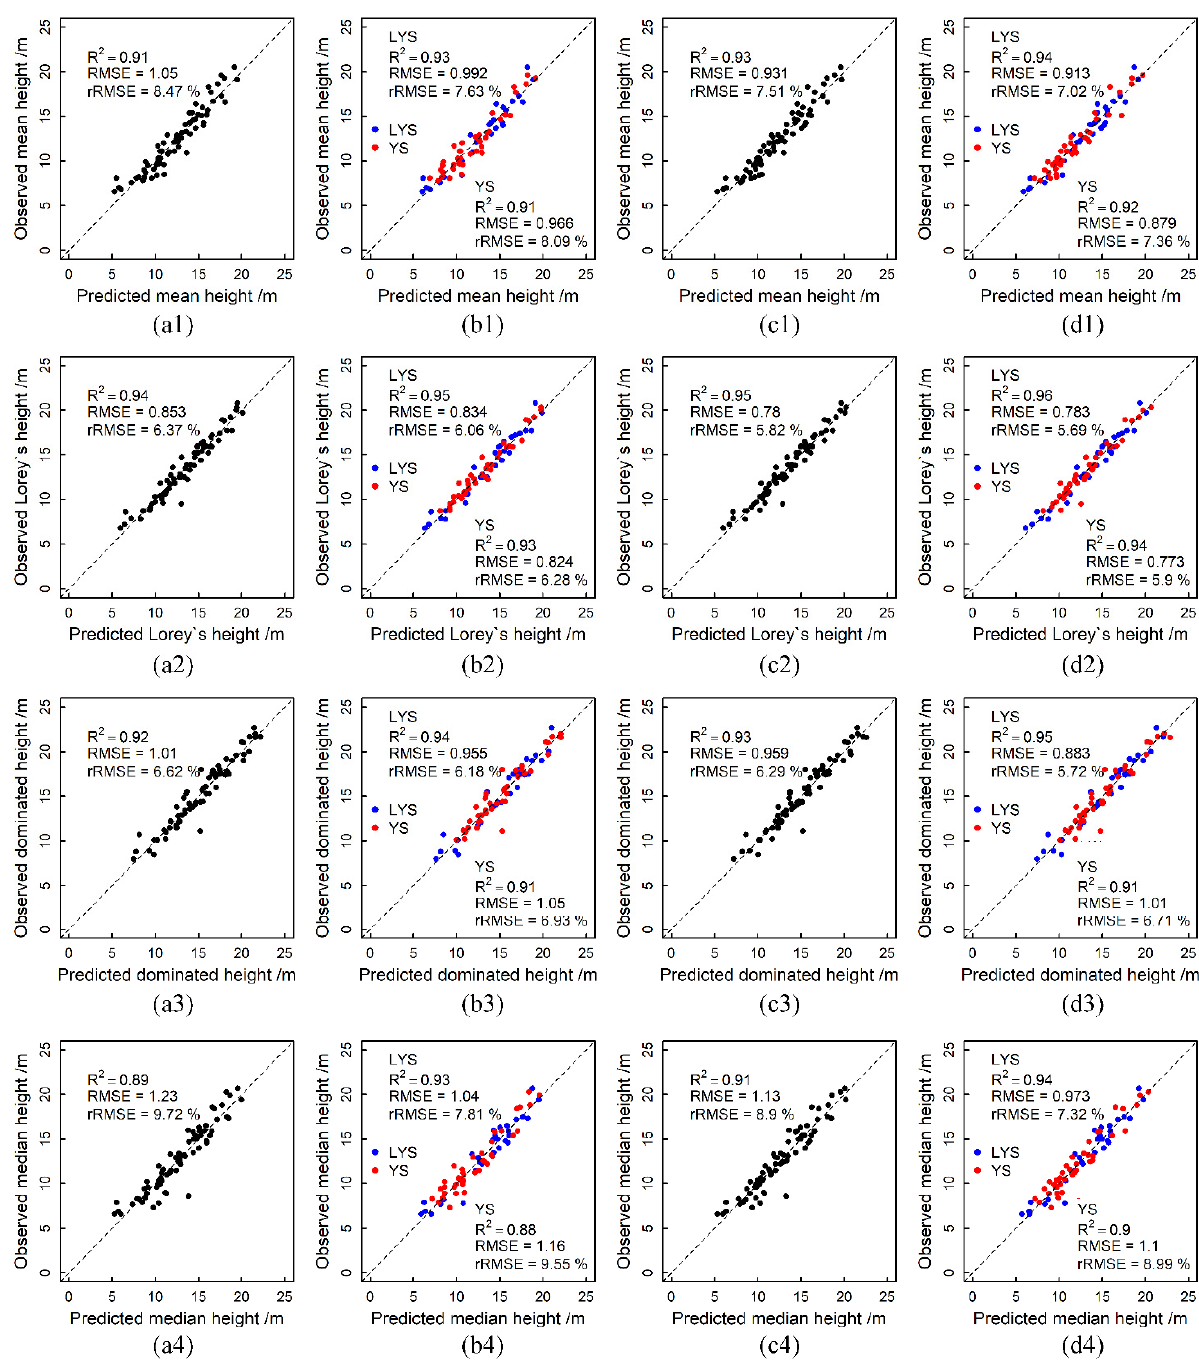
Figure 10. Scatterplots of estimated forest stand height and field measured height using ULS metrics. ( a1 – a4 , b1 – b4 ) for L-NPC. ( c1 – c4 , d1 – d4 ) for L-CHM.